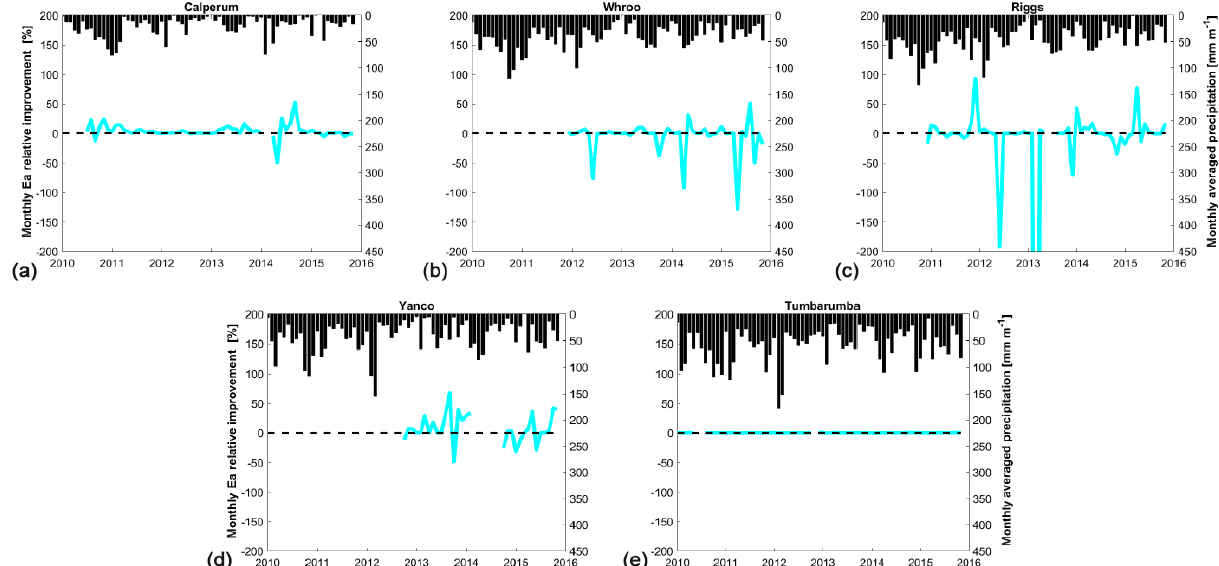
Figure 11. Effect of the assimilation on simulated evapotranspiration. Monthly rainfall and percentage improvement of simulated monthly evapotranspiration as a result of SMOS Tb assimilation for each individual flux tower measurement. Flux tower locations are sorted from west (a) to east (e)